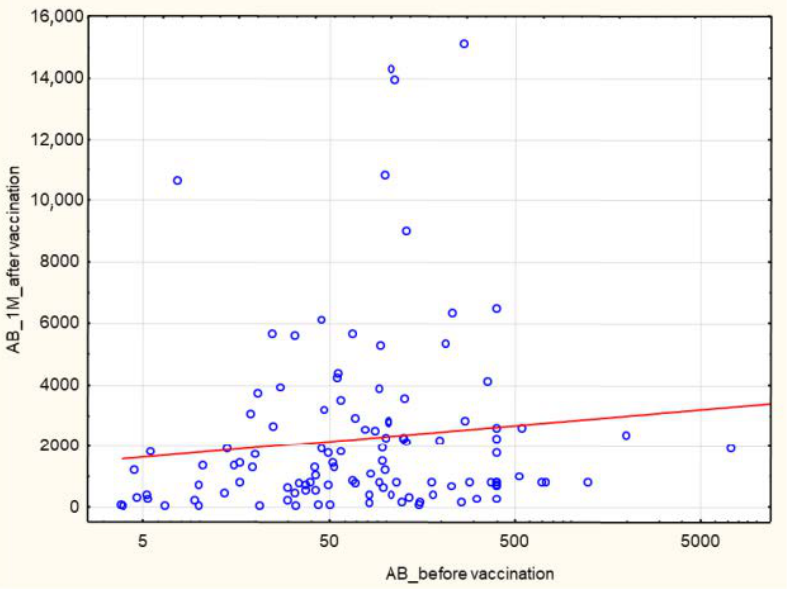
Figure 13. Positive correlation between pre-vaccination AB levels and the AB levels at 1 month after the 2nd dose of SARS-CoV-2 vaccine (AU/mL). ( p = 1.1 × 10 – 14 , R 0.47). Spearman’s rank correlation test. AB: antibody. Pre-vaccination AB levels correlated positively with the post-vaccination cellular response rate ( p = 7.95 × 10 –09 , R 0.43) (Figure 14).